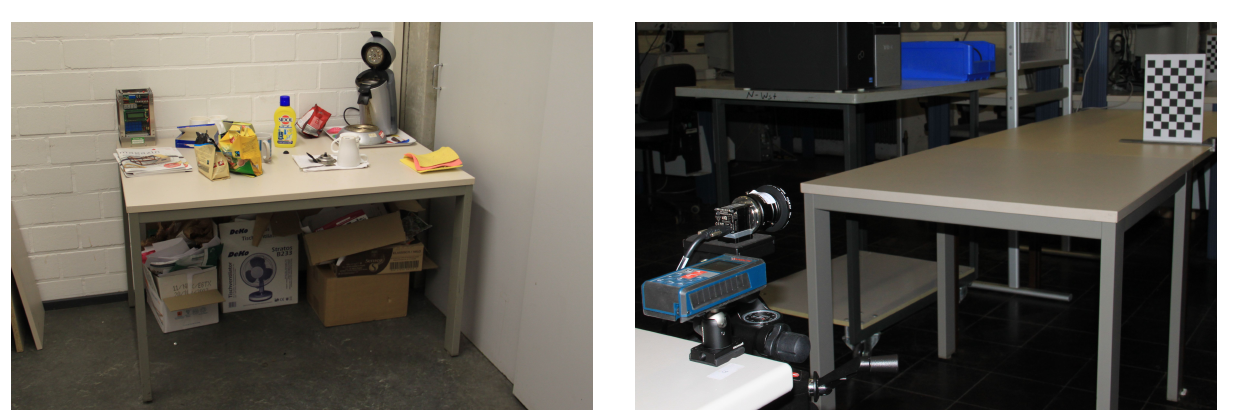
Figure 3. For the shown scene an image sequence of 400 frames was recorded by the Raytrix R5 camera and evaluated by visual odometry.